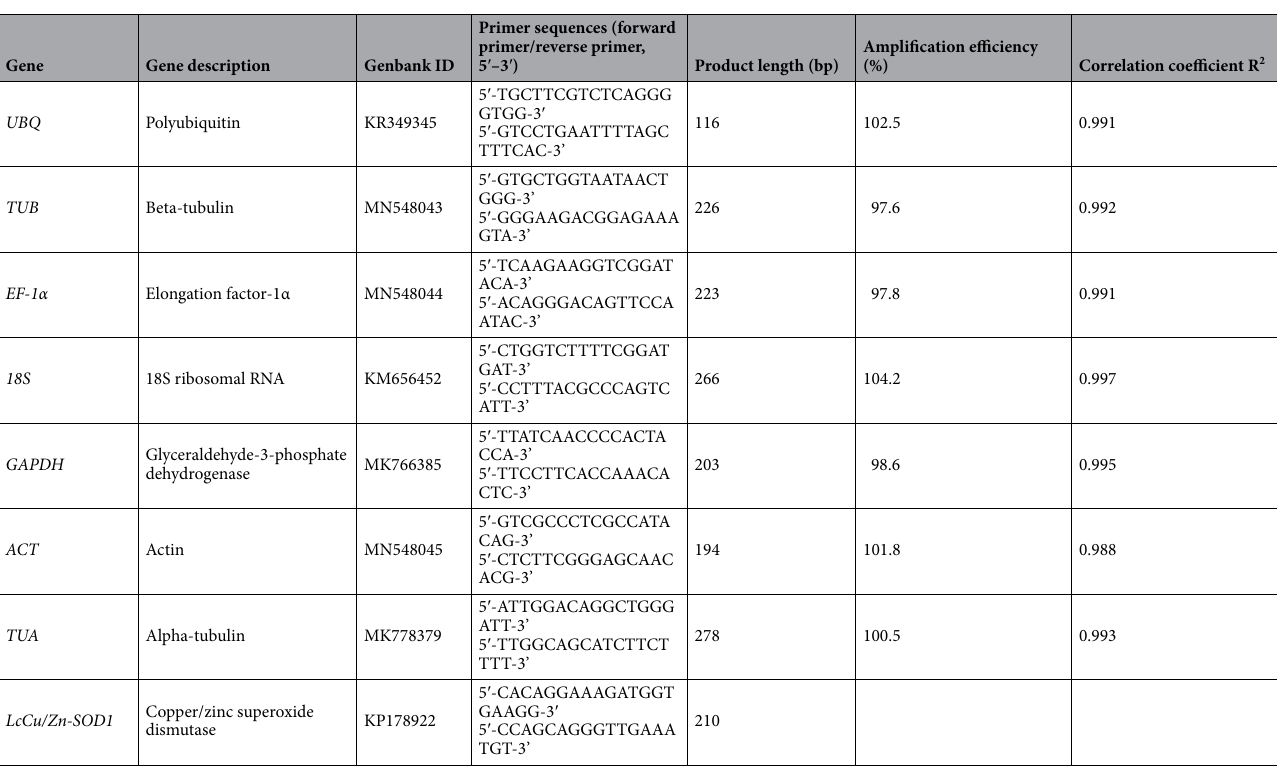
Table 1. Details on primers used for qRT-PCR analysis.